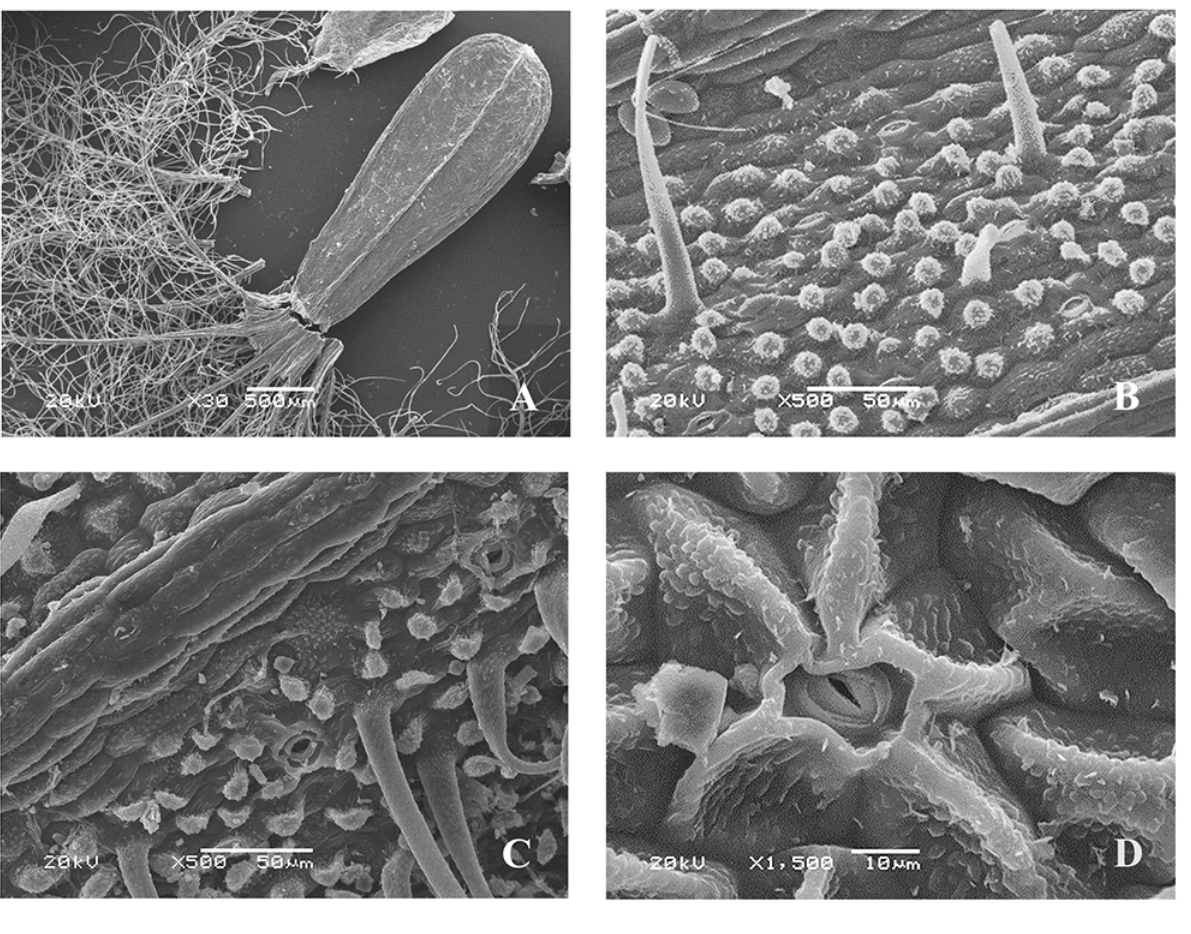
Figure 6 Fruit of Valeriana officinalis L. (SEM): General view ( A ); fragments of the fruit surface ( B,C ); stomium ( D ).